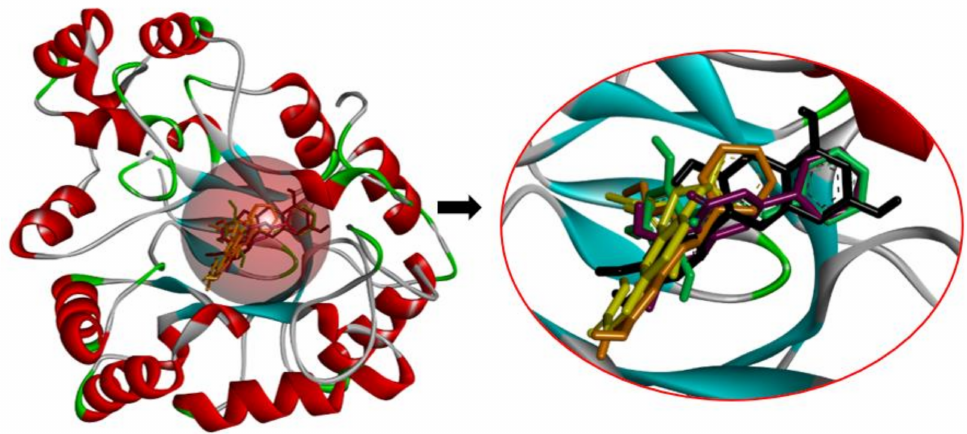
Figure 4. Binding positions of five potential anti-T2DM Asian propolis compounds in the active site of aldose reductase (AKR1B1) (PDB ID: 3G5E). The compounds are shown in various ligand colors; (color—number code of compound) yellow—41, green—51, black—353, violet—359,